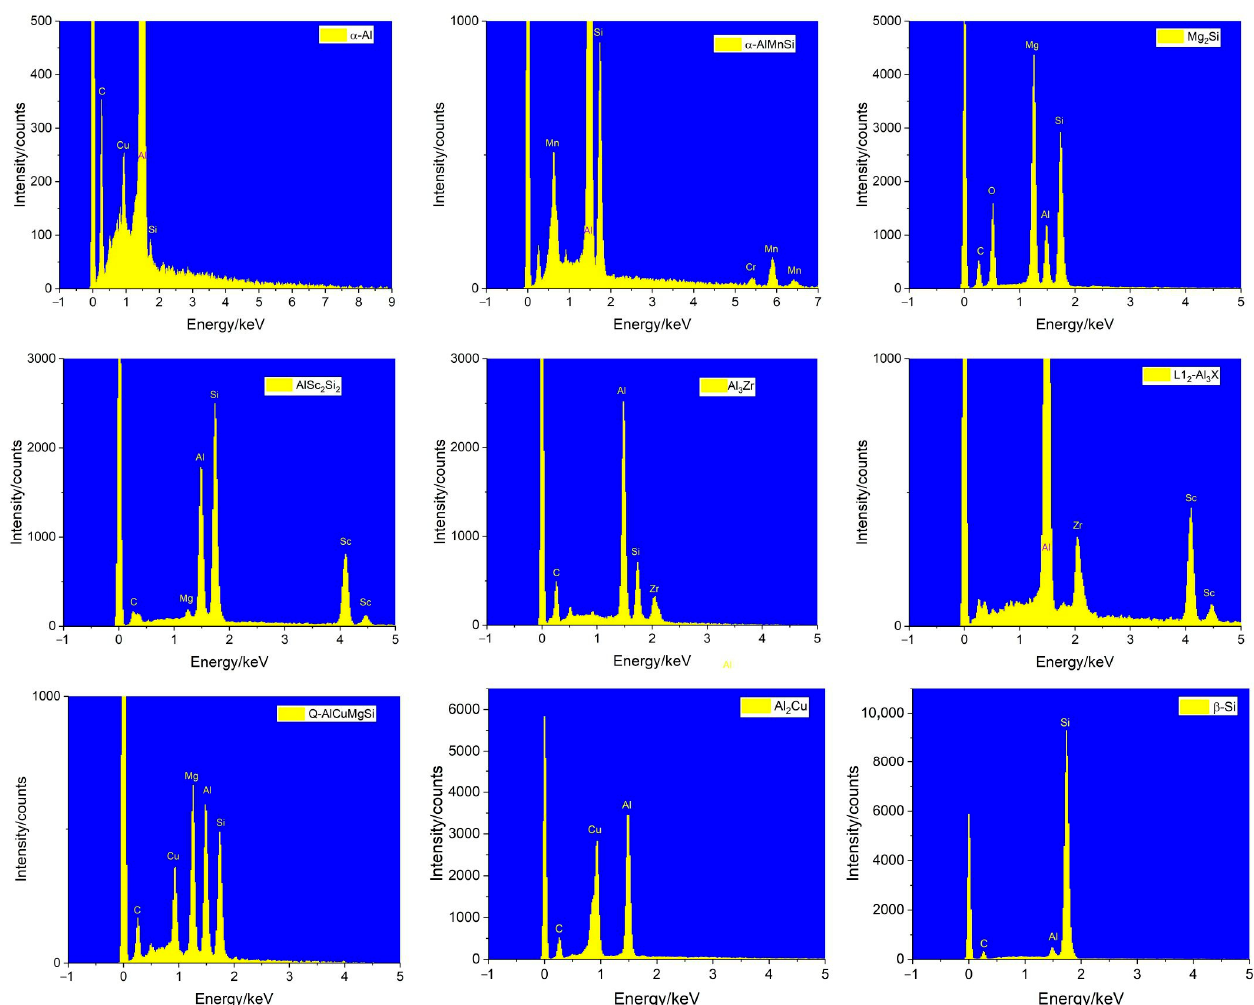
Figure 7. EDS spectra of phases encountered in the investigated alloys. Carbon arises from the surface contamination, and oxygen from the surface oxidation. The first peak on the left (at 0 keV) is the zero strobe.